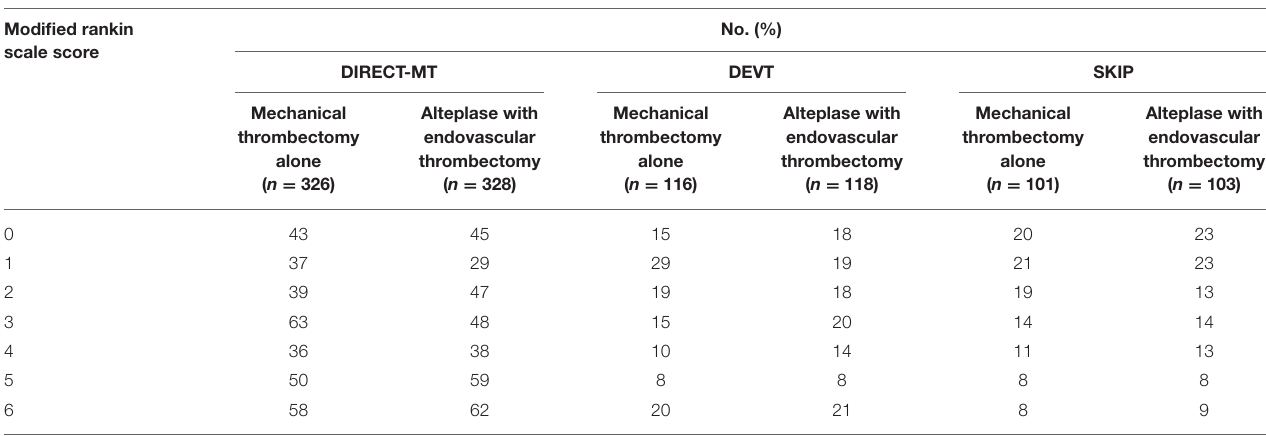
TABLE 3 | Distribution of 90-day modified Rankin scale scores.